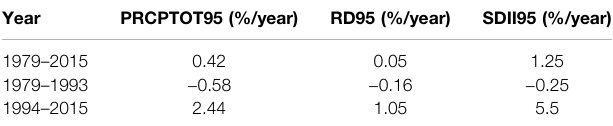
TABLE 2 | Comparison of the evolution of precipitation anomaly percentage difference during different stages of urbanization in the Sichuan –